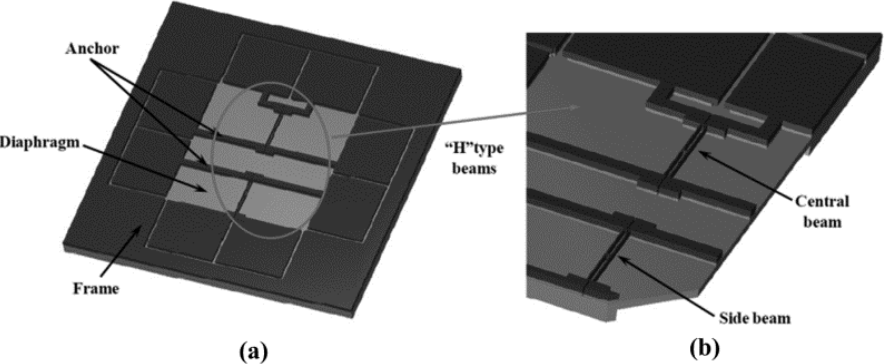
Figure 22. (a) Overall and (b) Partial enlarged SEM schematic of pressure sensors. Reproduced with permission from [118].